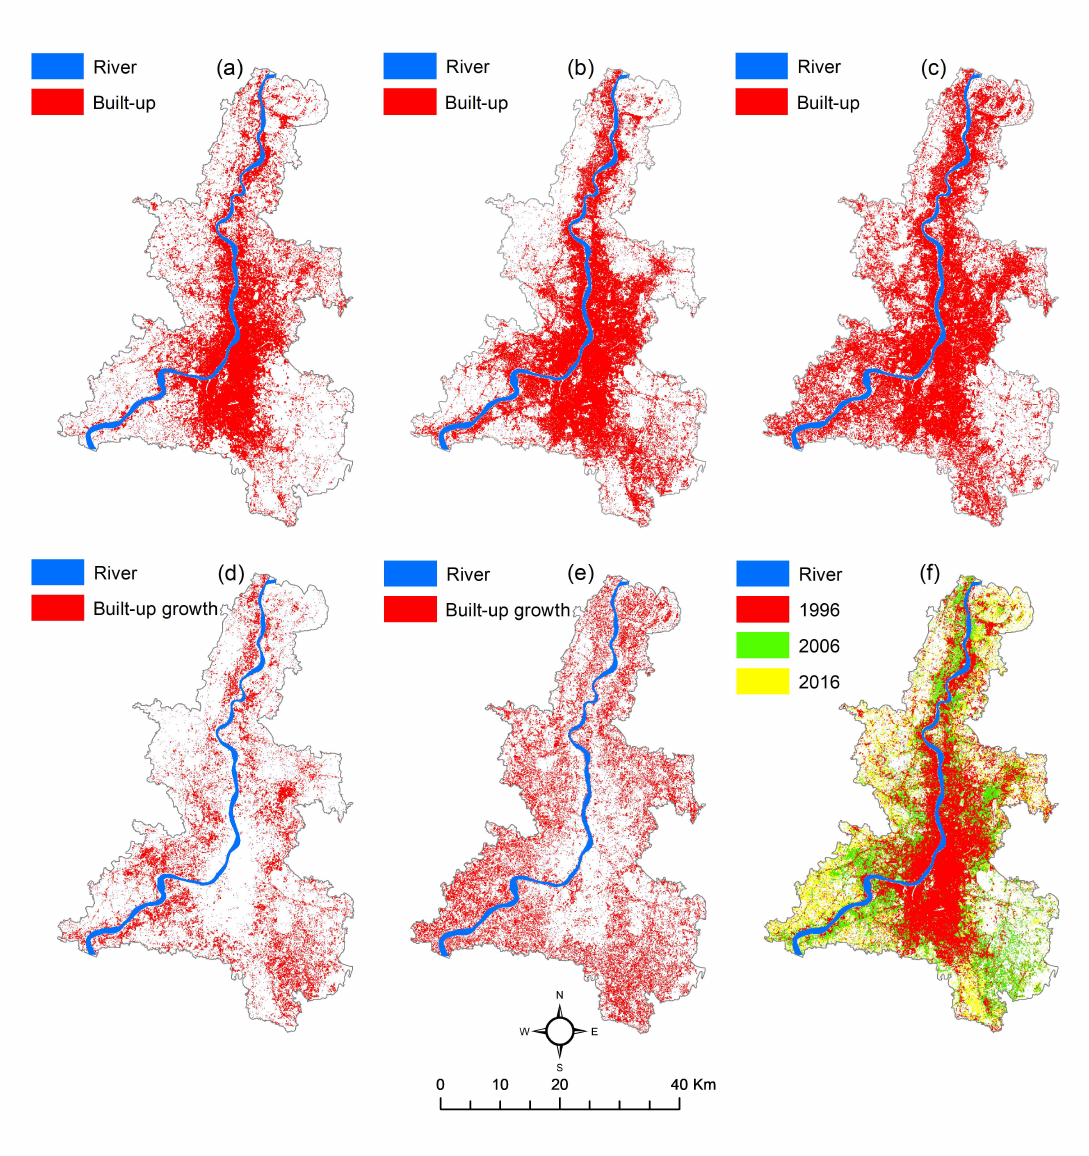
Figure 3. Total built-up spread and dynamics in KMA from 1996 to 2016: ( a – c ) present spatial built-up spread over KMA for 1996, 2006, and 2016, respectively; the decadal built-up growth during 1996–2006 and 2006–2016 are portrayed by ( d , e ), respectively; while ( f ) reflects built-up spread in 1996, 2006, and 2016 over KMA